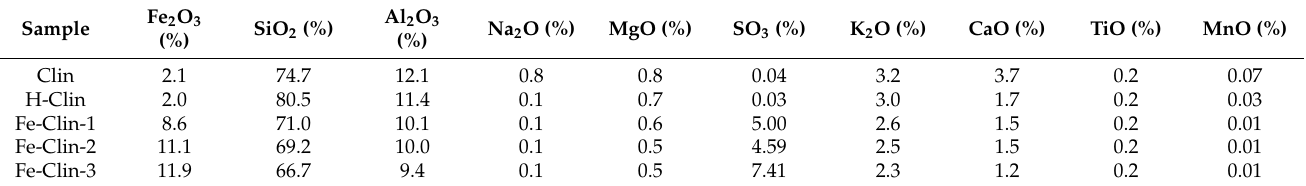
Table 1. Chemical composition (in wt.%) of the analyzed materials determined by